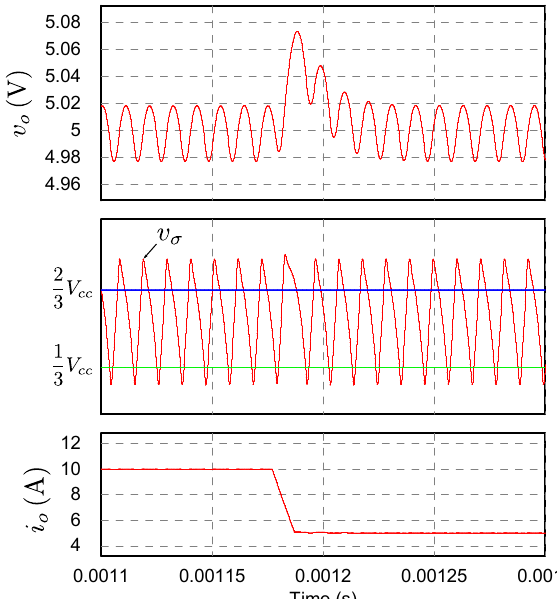
Figure 16. Simulated response to a load current step in the buck converter from 10 A–5 A corresponding to Figure